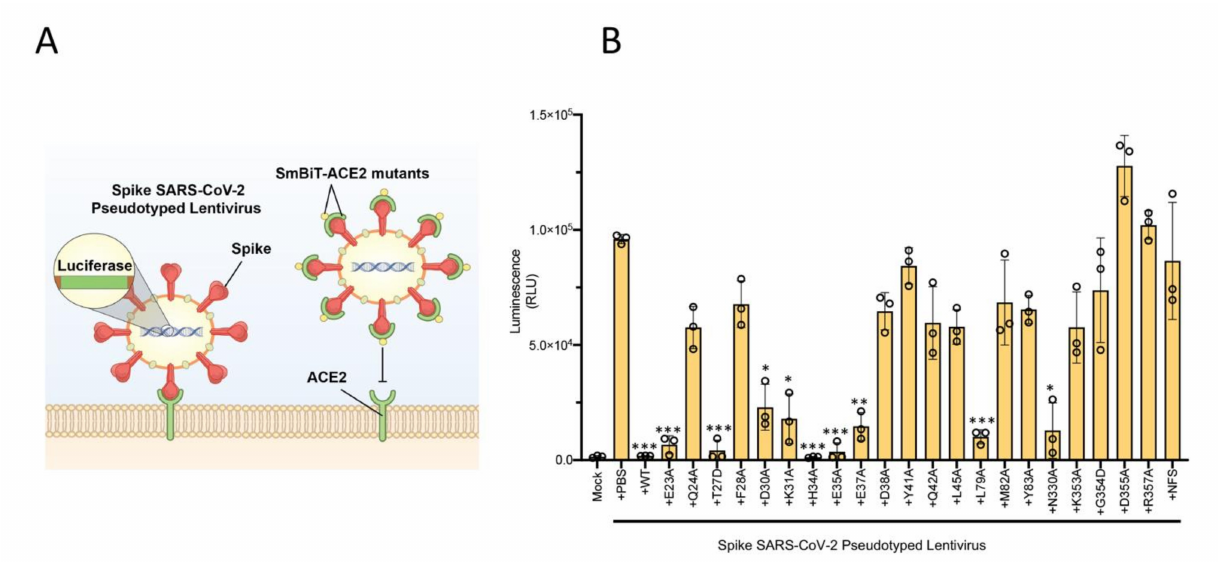
Figure 4. Lentiviral pseudovirus infectivity assay of ACE2 mutational analyses reinforces critical host and viral determinants of ACE2–RBD interaction. ( A ) Schematic of the lentiviral SARS-CoV-2 pseudovirus infectivity assay demonstrating spike- pseudotyped lentiviral attachment to ACE2 host receptor or mutant ACE2 proteins. ( B ) Lentiviral pseudovirus infectivity assay demonstrating the capacity of each mutant examined to act as a competitive inhibitor for the spike–host ACE2 interaction. * p < 0.05, ** p < 0.01, *** p <